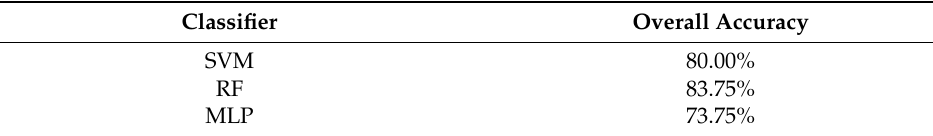
Figure 8. The classification results for urban deciduous and coniferous trees: ( a ) SVM; ( b ) RF; ( c ) MLP. Table 2. Overall accuracy values of the proposed three classification